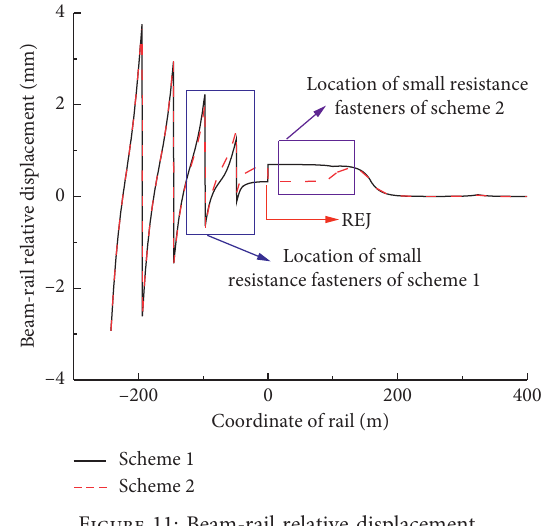
Figure 11: Beam-rail relative displacement.